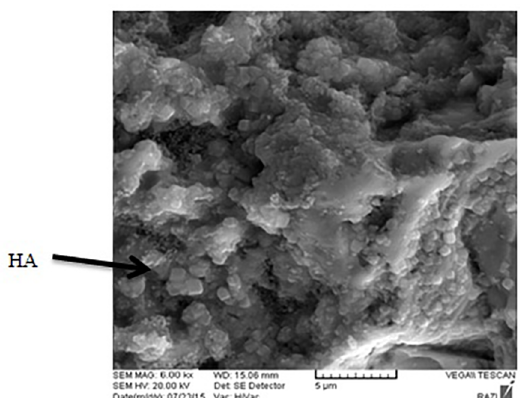
Figure 8. SEM image of pressed sample under compaction pressure of 700